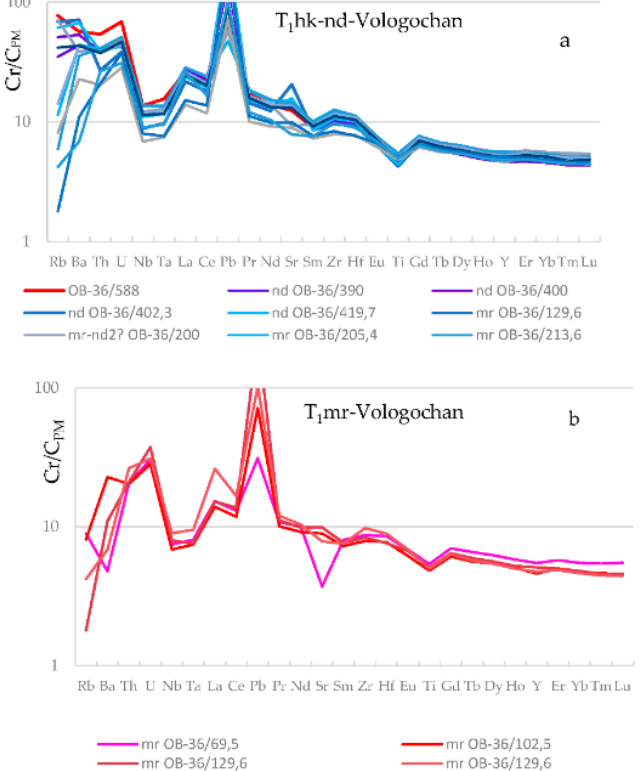
Figure 15. Spider-diagrams for rocks of the Khakanchansky, Nadezhdinsky ( a ), and Morongovsky ( b ) Formations in the Vologochan